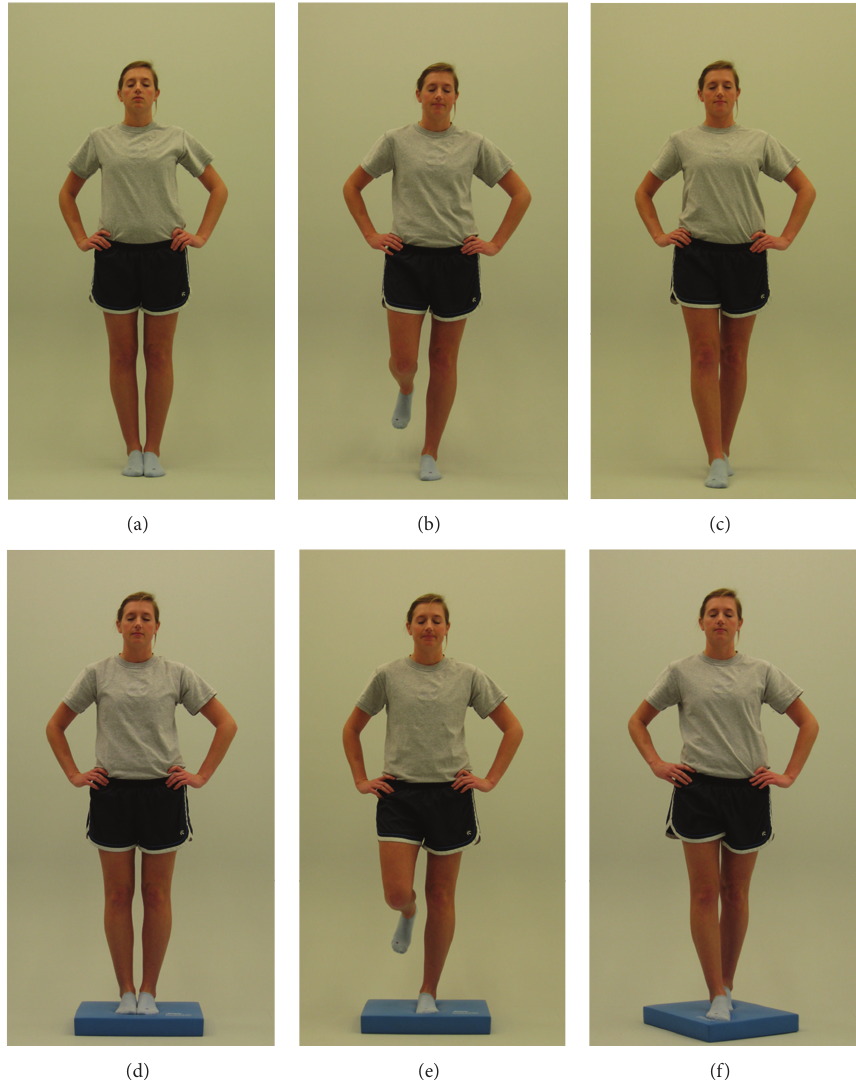
Figure 1: Balance error scoring system (BESS) performed on firm surface ((a)–(c)) and foam surface ((d)–(f)). Figure reprinted with permission from Davis et al.